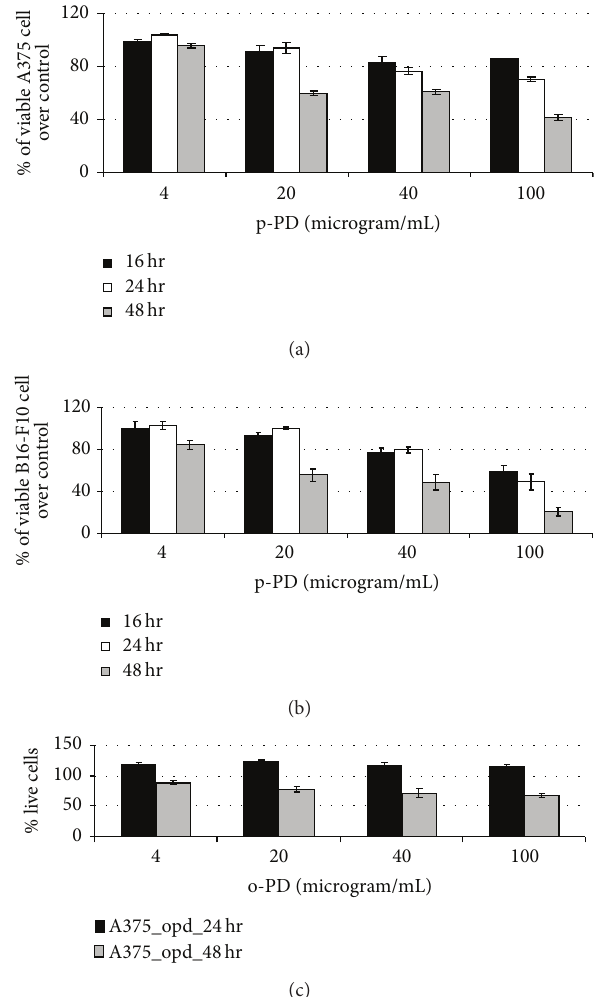
Figure 1: Cytotoxic effect of para-phenylenediamine and ortho- phenylenediamine (o-PD) on melanoma cells . A375 (a) and B16- F10 (b) cells grown in a 96-well (5000 cells in each well) plate were treated with p-PD of indicated concentrations for 16, 24, and 48 hours at 37 ∘ C. (c) In a similar manner, A375 cells were also treated with o-PD for 24 and 48 hours with indicated concentrations. Four wells were used for each concentration in every time point. One set of untreated cells (0.1% DMSO) was kept as control for each time point. The absorbance reading (OD) for each set obtained from the microplate reader was used to compute the percent change in viable cell in treated sets over respective controls using the expression − OD ) × 100/ OD } . The % viable cell over {( OD Control Experimental Control control was plotted against respective concentrations of p-PD. Error bars represent SD; 𝑛 = 4